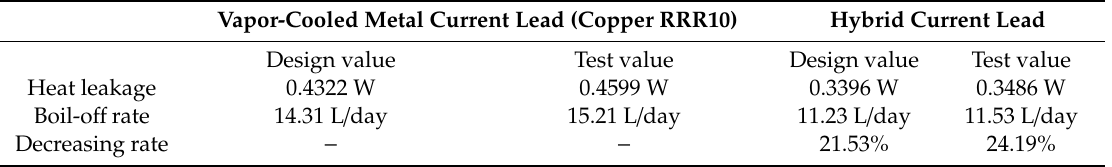
Table 3. Summary of experimental results as compare with the design